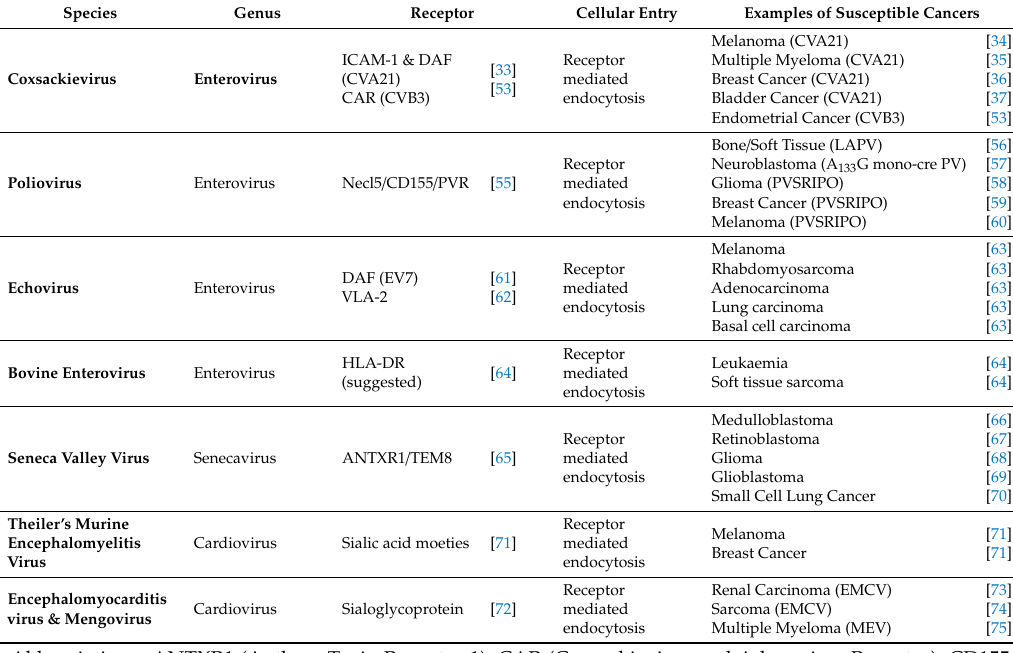
Table 2. Receptors and tissue tropisms of oncolytic